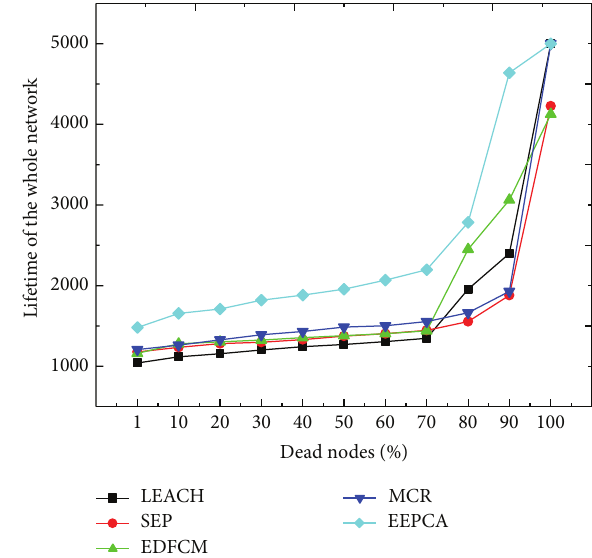
Figure 13: Packets to sink with varying priority percentage.